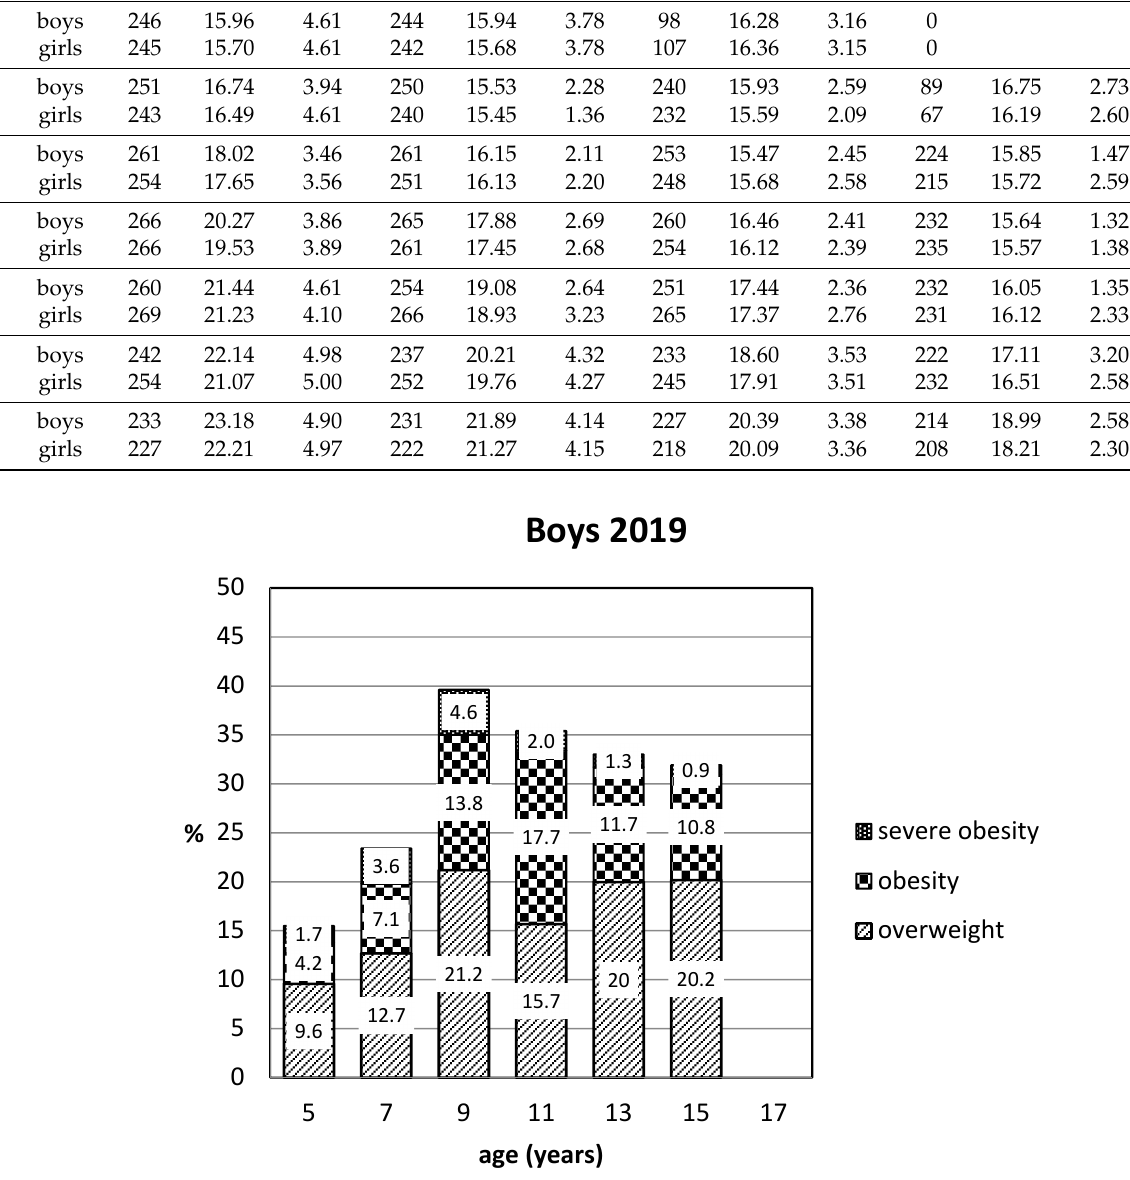
Figure A1. Prevalence of overweight, obese, and severely obese boys in 2019.